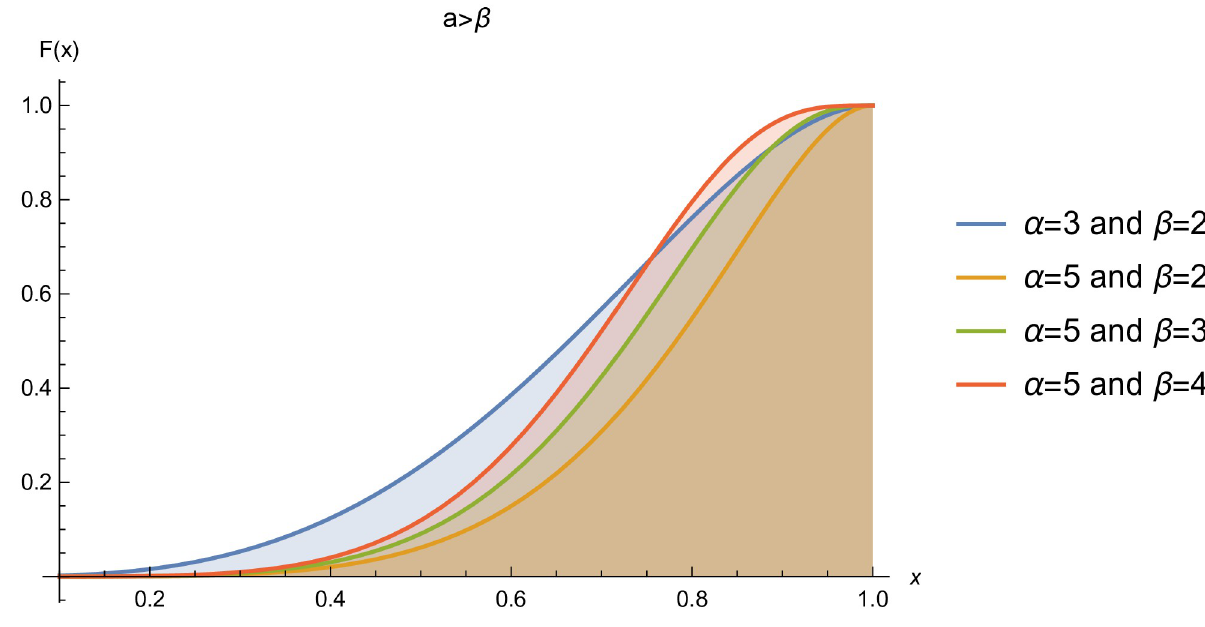
Fig 6. cdf of Kum ( α , β ), when α > β